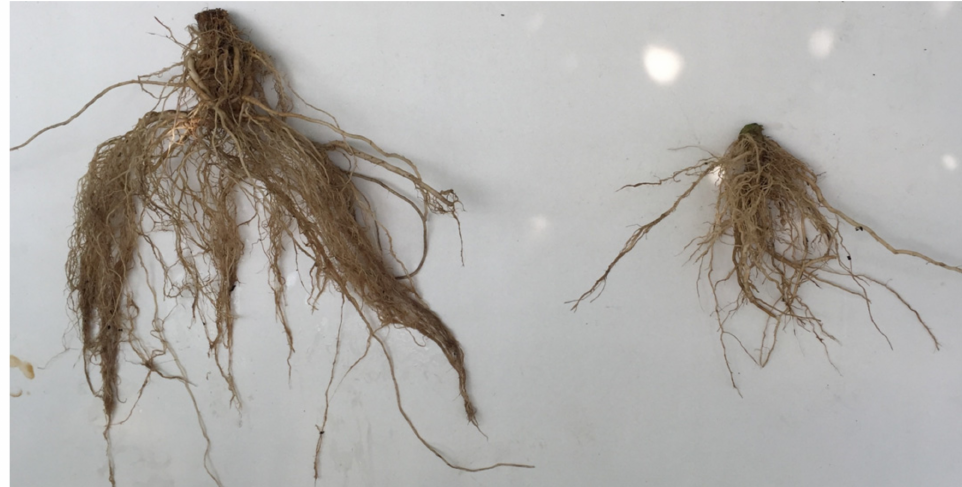
Figure 2. Root growth of representative tomato plant between substrate-based ( left ) and soil cultivation ( right